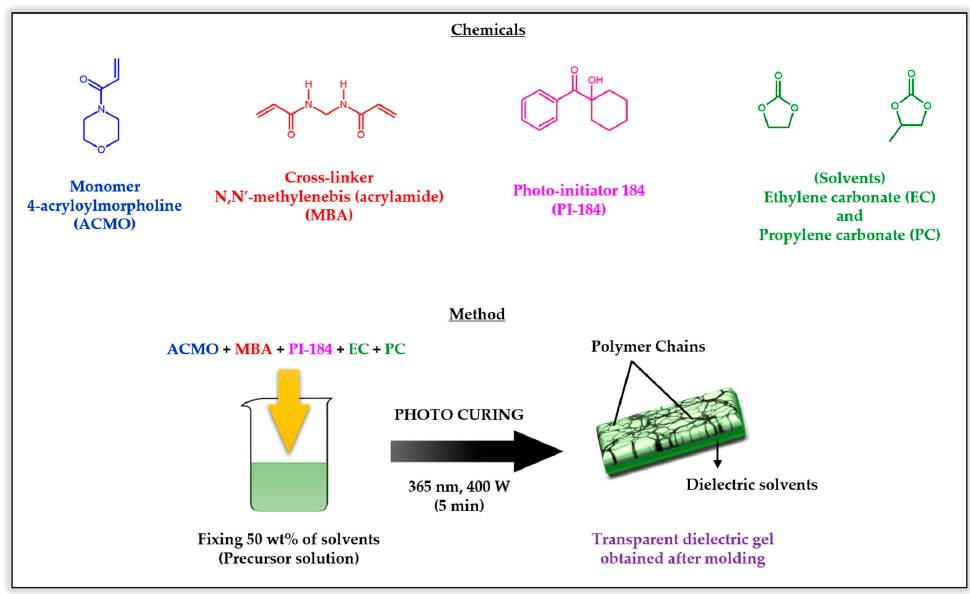
Figure 4. Schematic representation of the transparent dielectric gel formation using ACMO (monomer), MBA (cross-linker) and EC–PC solvents. Adapted with permission from [105], Springer Nature,